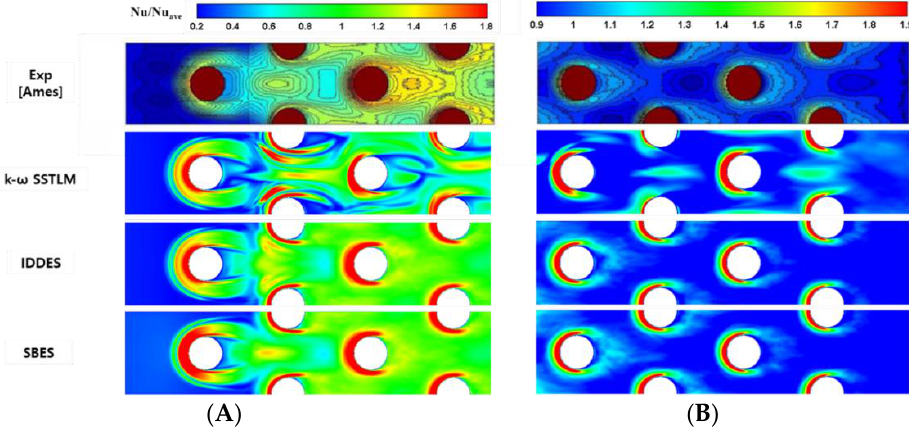
Figure 10. Nusselt number distributions normalized by surface average Nusselt numbers. ( A ) Upstream region, ( B ) downstream region. region, ( B ) downstream